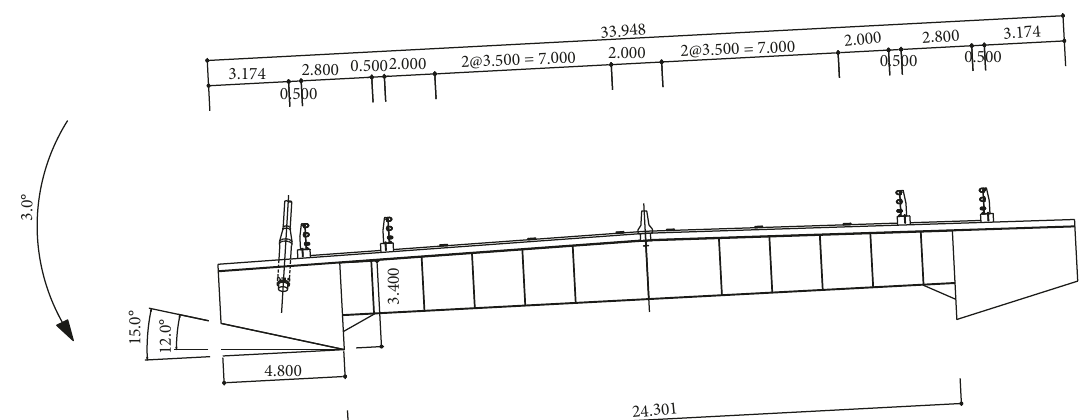
Figure 4: The concept of physical AOA (AOA of − 3 ° with the box slope of 15 ° ).